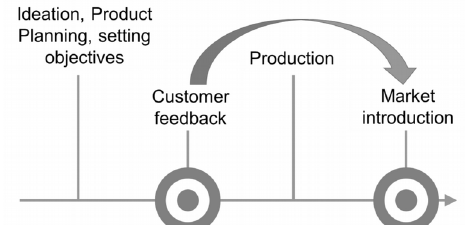
Figure 1. According to the classical timeline of product development initiatives, customer feedback could be no longer effective at the time of market launch, with clear repercussions in terms of